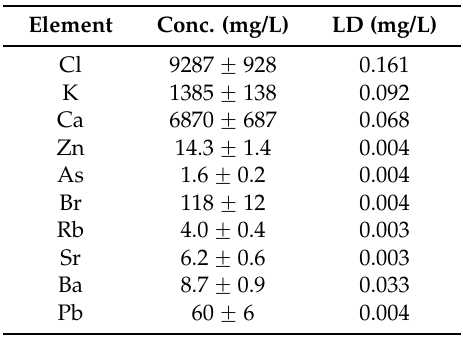
Table 2. Elements concentration and limits of detection (LD) in leaching solutions of MSWI fly ash.